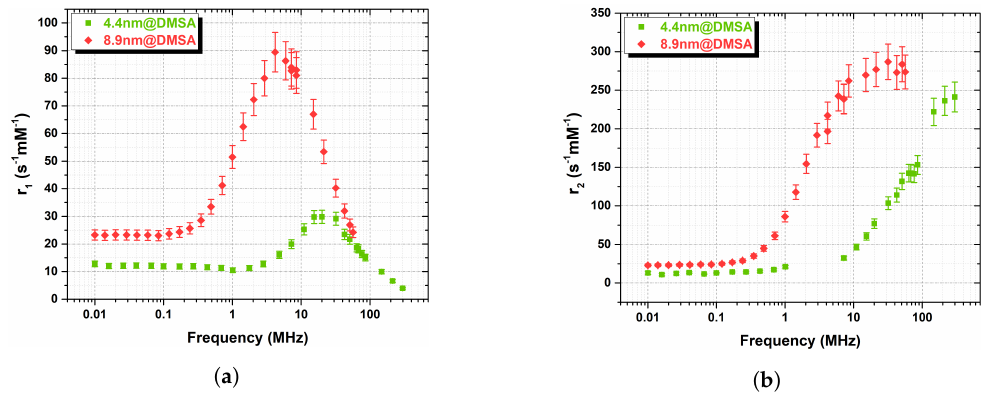
Figure 8. Comparison among the 1 H-NMRD relaxation profiles of the 4.4@DMSA (green squares) and the 8.9@DMSA (red diamonds) longitudinal ( a ) and transverse ( b )